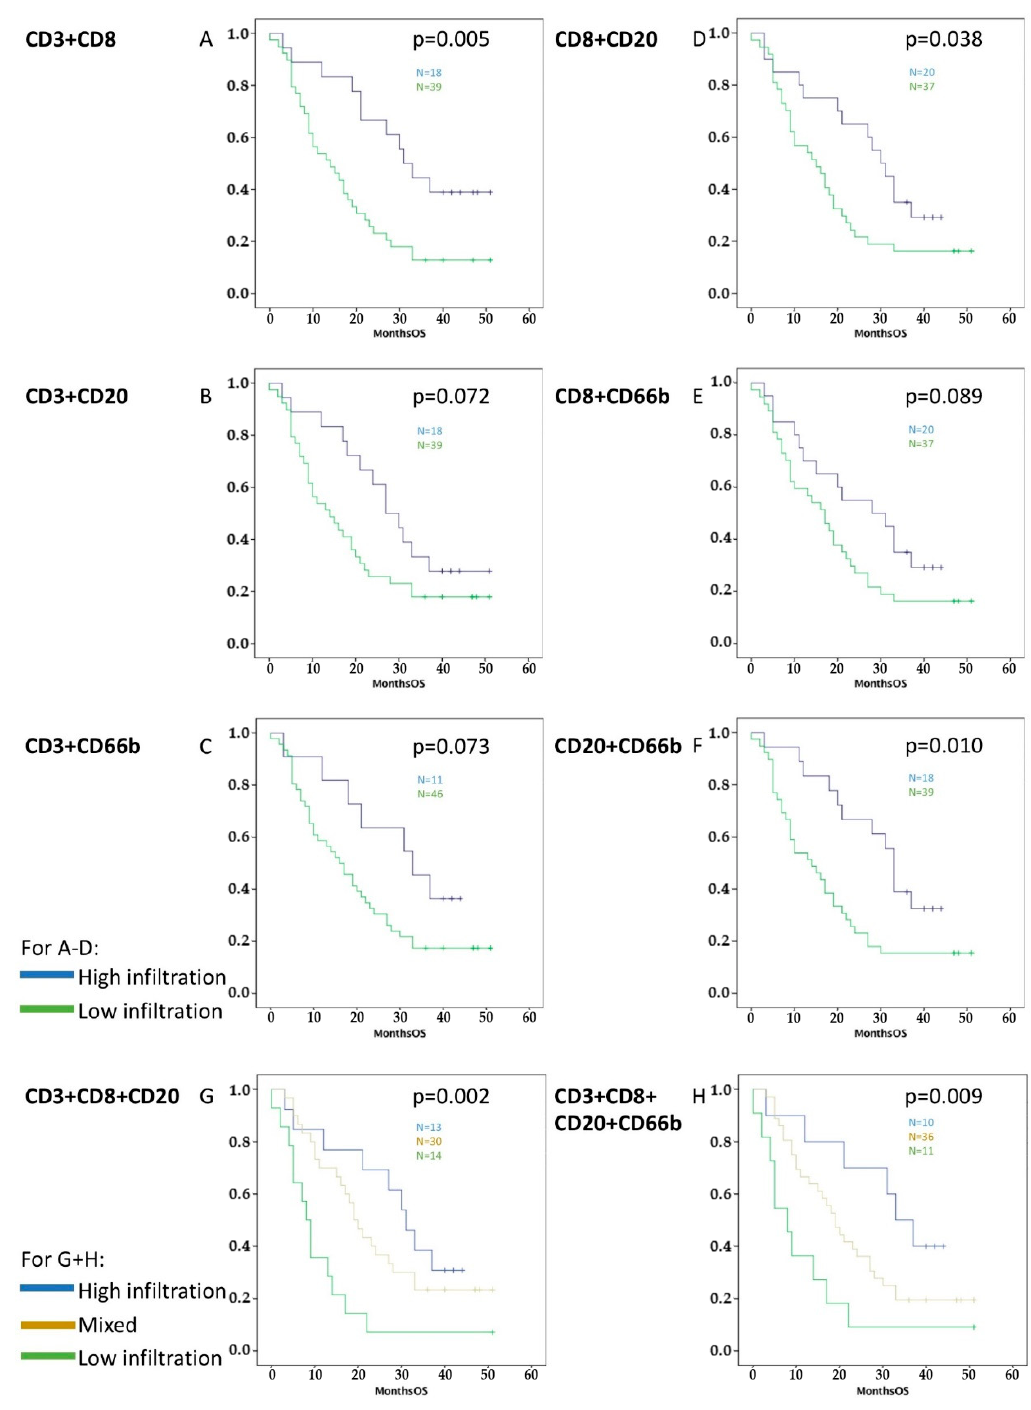
Figure 2. Survival graphs of OS in relation to different combinations of TILs and TINs: Groups were formed by separating high infiltration in both cell types (blue color, e.g., high CD3 + and high CD8 + ) from the rest (green color, e.g., high/low CD3 + /CD8 + or low CD3 + and low CD8 + ), where two immune cells were analyzed together ( A – F ). Groups were formed by separating high infiltration in all cell types, low infiltration in all cell types, and mixed levels of infiltration, where three immune cells were analyzed together ( G ). Finally, combination with four immune cells was performed ( H ). High infiltration of CD3 + /CD8 + , CD3 + /CD8 + /CD20 + , CD8 + /CD20 + , CD20 + /CD66b + , and CD3 + /CD8 + /CD20 + / CD20 + /CD66b + tumor-infiltrating leukocytes correlated significantly with better OS.